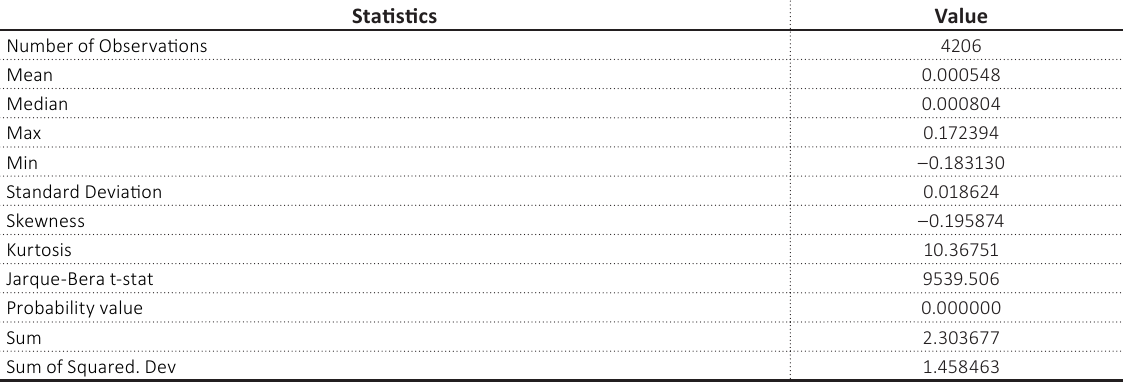
Figure 3. Normal QQ plot for daily Bank Nifty Index returns: Table 3. Results showing summary statistics